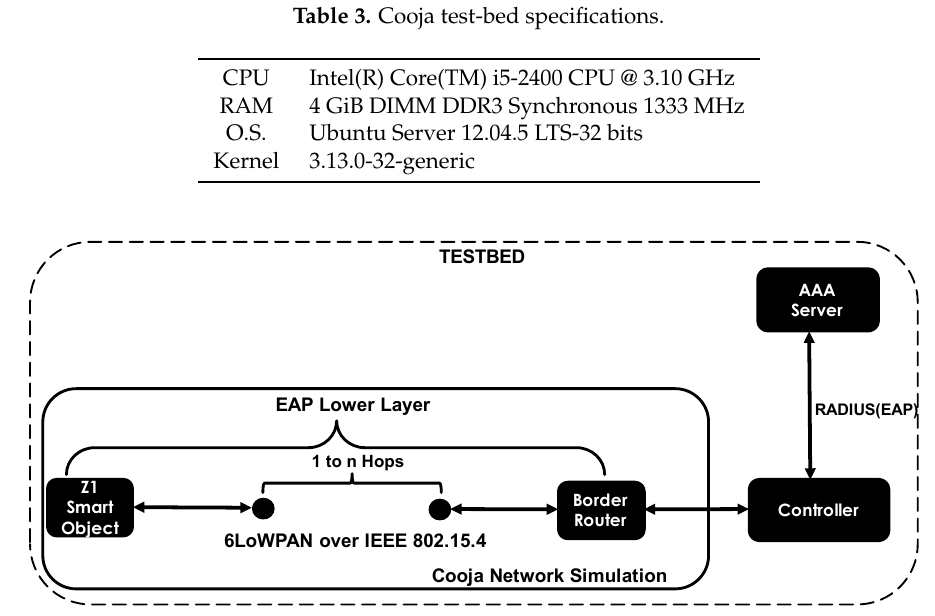
Figure 5. Cooja test-bed.